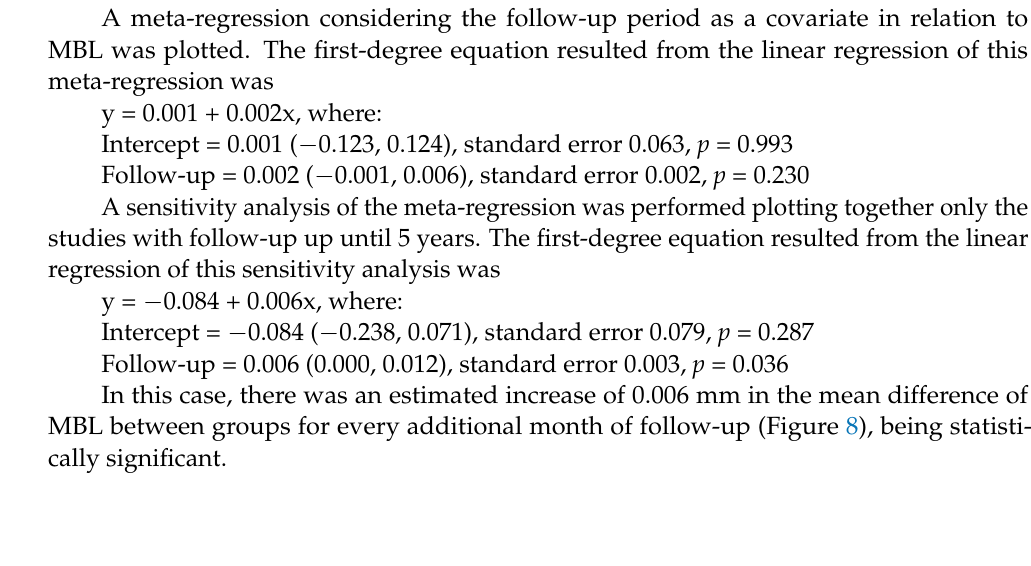
Figure 7. Scatter plot for the meta-regression with the association between the odds ratio (OR) of failure between implants placed in fresh extraction sockets and implants placed in healed sites, and the follow-up time (in months; limited to 60 months). Every circle represents a study, and the size of the circle represents the weight of the study in the